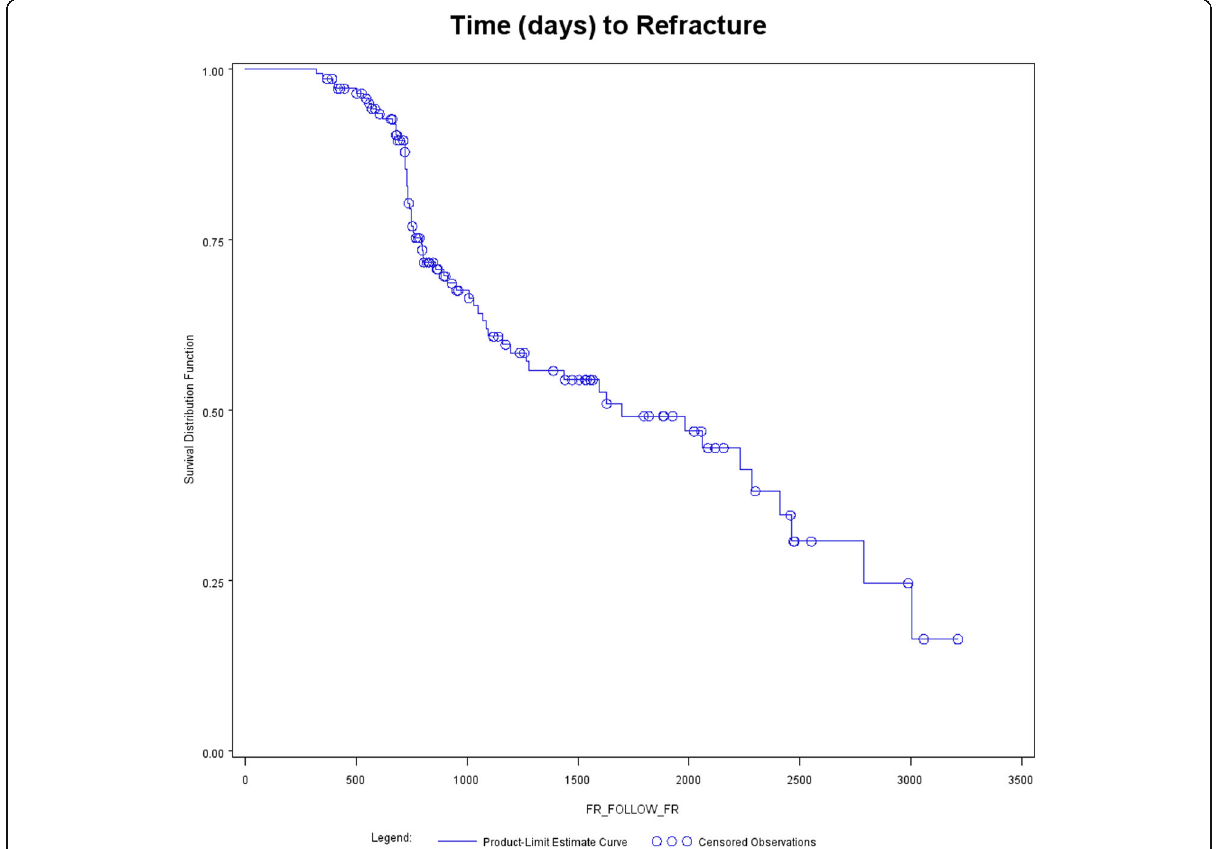
Fig. 2 Kaplan-Meier estimate of the probability of not having a